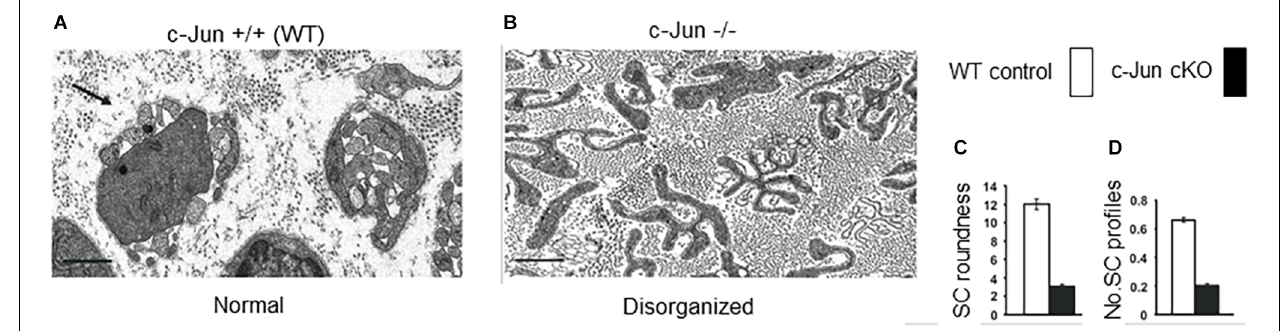
FIGURE 7 | The structure of regeneration tracks (Bungner bands) is regulated by Schwann cell c-Jun. Electron micrographs showing transverse sections of the distal stump of mouse sciatic nerve 4 weeks after cut. (A) WT nerve showing normal Bungner bands. (B) c-Jun cKO nerve showing distorted Bungner bands. (C,D) Quantification of the roundness and number of Schwann cell profiles in Bungner bands. Scale bar 1 µ m (modified from Arthur-Farraj et al., 2012).